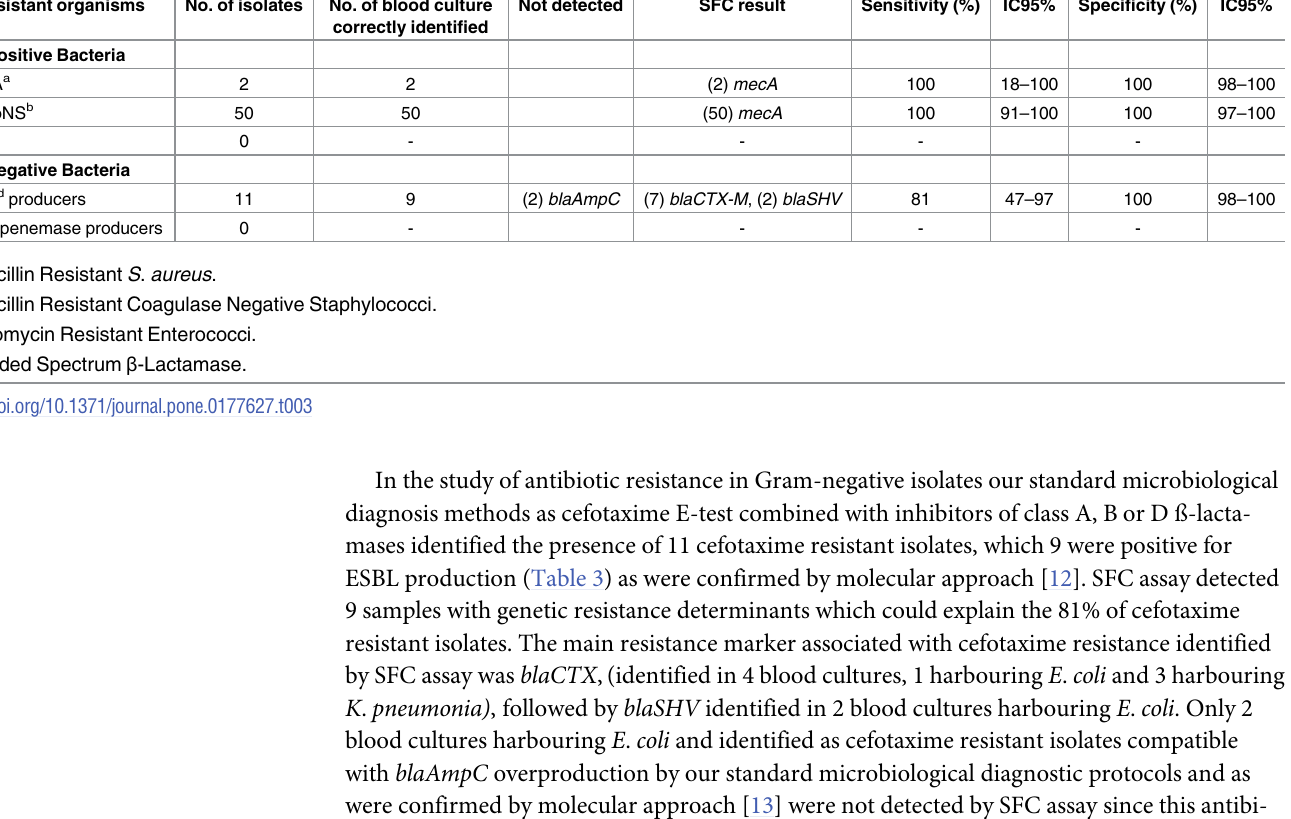
Table 3. Sensitivity and specificity of SFC assay in detection of genetic resistance determinants from positive blood culture samples. Drug resistant